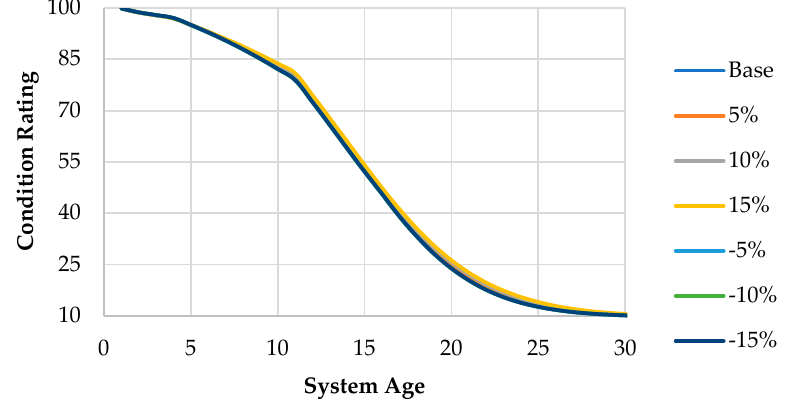
Figure 3. Output alteration upon age parameter incrementation.